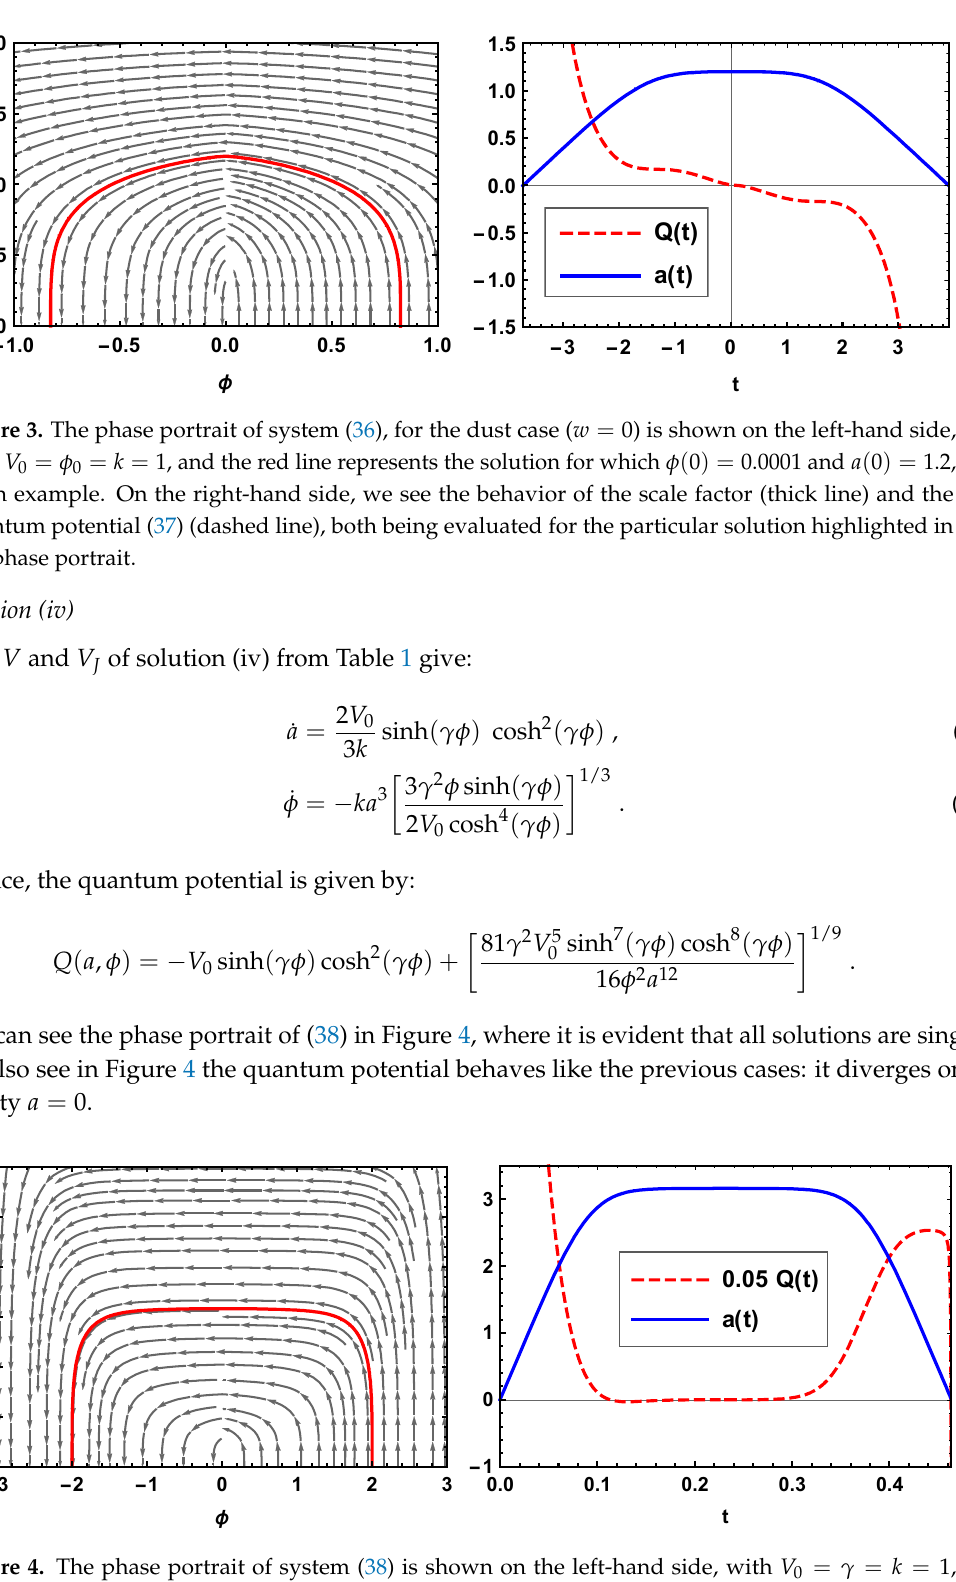
Figure 4. The phase portrait of system (38) is shown on the left-hand side, with V 0 = γ = k = 1, and the red line represents the solution for which φ ( 0 ) = 2 and a ( 0 ) = 0.001, as an example. On the right-hand side, we see the behavior of the scale factor (thick line) and the quantum potential (39) (dashed line), both being evaluated for the particular solution highlighted in the phase